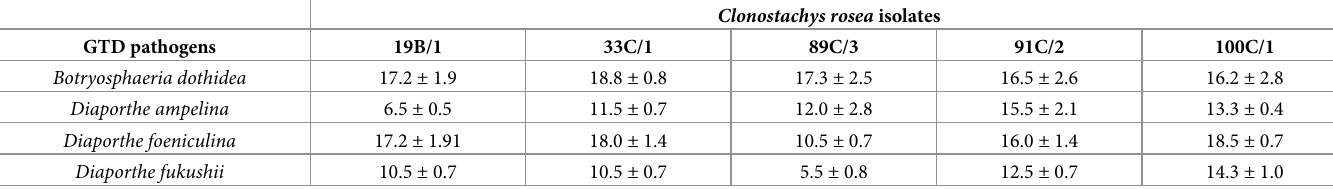
the woody tissues just under the bark of the cuttings (Fig 4A). The length of the necrotic Table 3. Mycoparasitism of GTD pathogen colonies by C . rosea